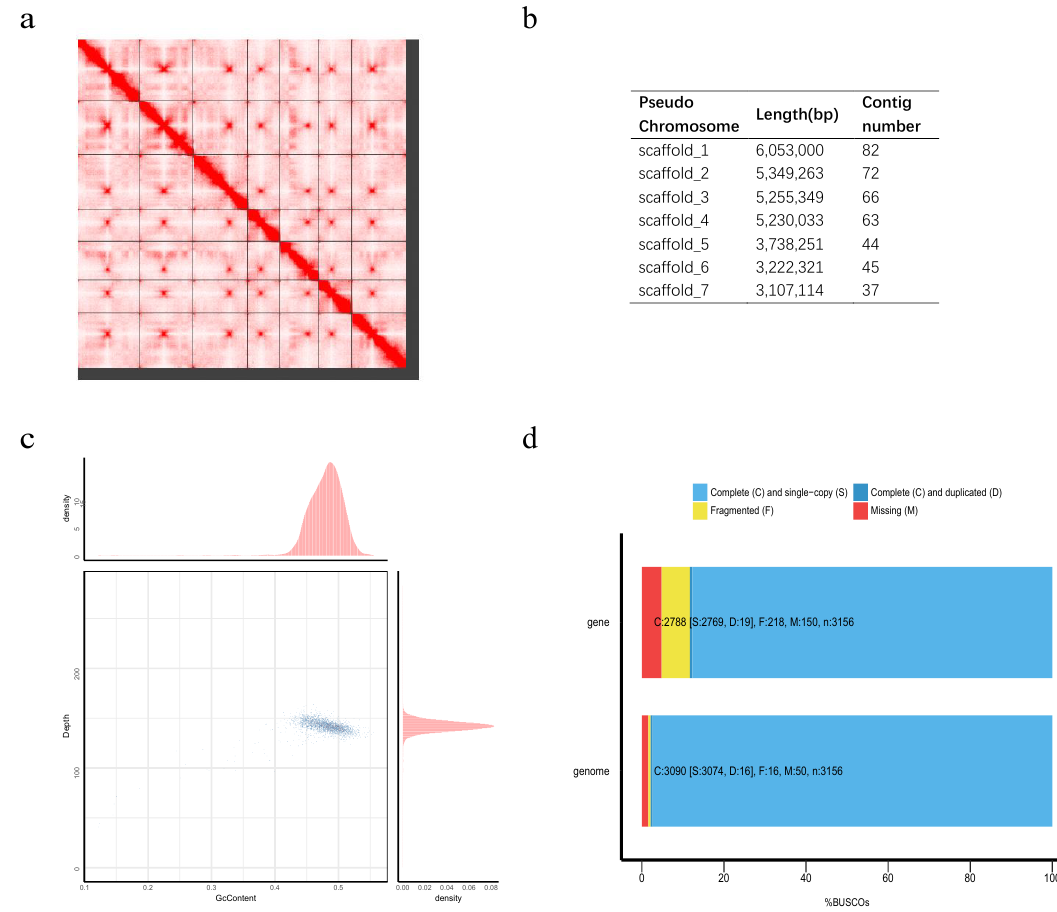
Figure 1. Summary of genome assembly and assessment. ( a ) The seven longest sca ff olds interactive heatmap of Penicillium variabile assembly. The horizontal and vertical lines divide the genome into seven major pseudochromosomes. Gradient red indicates the intensity of contact between sequences. The intra-contact of sequences in pseudochromosome is stronger than the inter-contact. ( b ) The length of each chromosome and involved contig number. ( c ) GC-depth distribution of final assembly. The horizontal coordinate represents the average GC content per 10 kb windows, and the vertical coordinate represents the corresponding coverage depth. The bar charts on the top and right represent the distribution of GC and coverage depth. ( d ) BUSCO (benchmarking universal single-copy orthologs) assessment of genome and gene set. The bar chart below is a BUSCO assessment of genome, of which 3090 genes (97.91%) are predicted to be complete including 3074 single copies and 16 duplications. The upper bar chart is a BUSCO assessment of gene set, of which 2788 genes (88.34%) are predicted to be complete, including 2769 single copies and 19